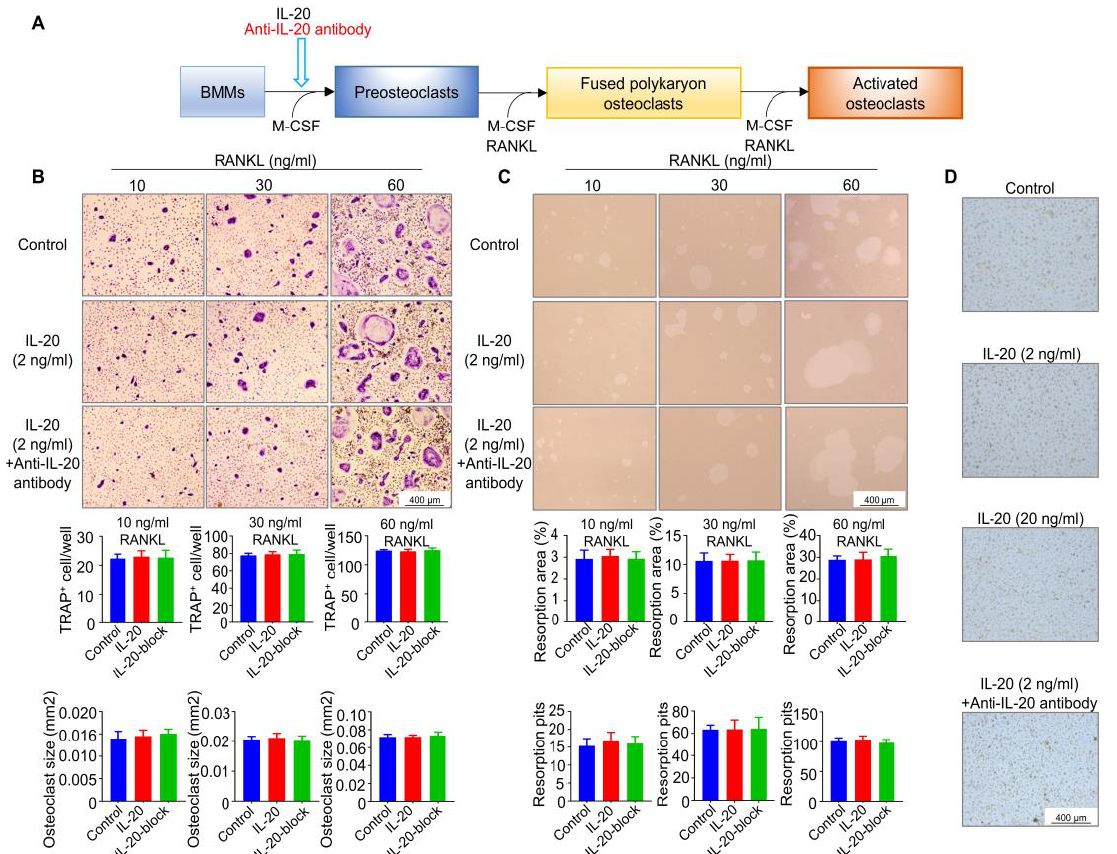
Figure 3. IL-20 had no effect on osteoclast formation at the early stage of osteoclast differentiation. ( A ) Scheme illustrating bone marrow-derived macrophages were cultured in osteoclast medium containing M-CSF and IL-20 or anti-IL-20 antibody at the early stage of osteoclast differentiation, and then induced with the presence of 10, 30, or 60 ng/mL RANKL. The control group included M-CSF-induced preosteoclasts induced with 10, 30, or 60 ng/mL RANKL. ( B ) TRAP staining was performed, and the number and size of TRAP-positive osteoclasts with more than three nuclei were quantified on day 6. IL-20-block group meant that cells were treated with IL-20 or anti-IL-20 antibody. ( C ) A bone resorption pit assay was performed to detect osteoclast function, and bone resorption pits were counted, and the area and number of bone resorption were quantified on day 6. IL-20- block group meant that cells were treated with IL-20 and anti-IL-20 antibody. ( D ) M-CSF-induced preosteoclasts were cultured in osteoclast medium containing different concentrations of IL-20 or anti-IL-20 antibody without RANKL. n =